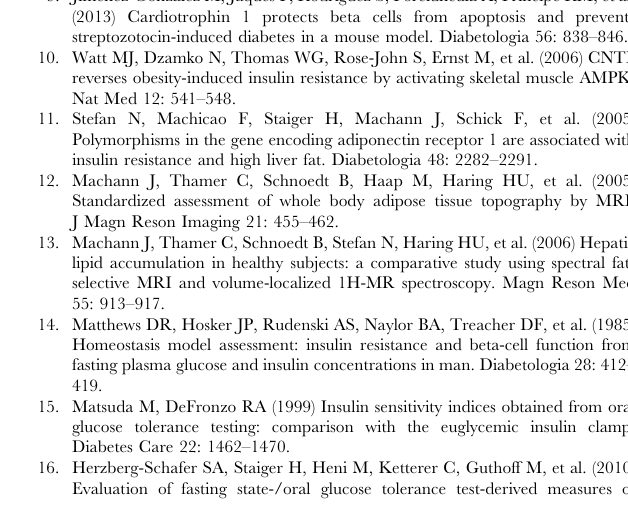
Table S1 Associations between CTF1 SNPs and parameters of body fat content/distribution. Data represents means 6 SD. Prior to statistical analysis, all measures were adjusted for gender and age. Nominal associations marked by bold fonts. BMI - body mass index; Waist - waist circumference; TAT - total adipose tissue; VAT - visceral adipose tissue; IHL - intrahepatic lipids. (DOC) Table S2 Associations between CTF1 SNPs and insulin secretion. Data represents means 6 SD. Prior to statistical analysis, indices of insulin secretion were adjusted for gender, age, BMI and ISI OGTT. AUC - area under the curve; Glc - glucose; Ins - insulin; HOMA-B - homeostasis model assessment of beta-cell function; ISI - insulin sensitivity index; OGTT - oral glucose tolerance test. Table S3 Associations between CTF1 SNPs and indices of lipid metabolism. Data represents means 6 SD. Prior to statistical analysis, indices of lipid metabolism were adjusted for gender, age, BMI and lipid-lowering medication. AUC - area under the curve; TG, triglyceride; Chol, cholesterol; LDL, low-density lipoprotein; HDL, high-density lipoprotein; VLDL, very low- density